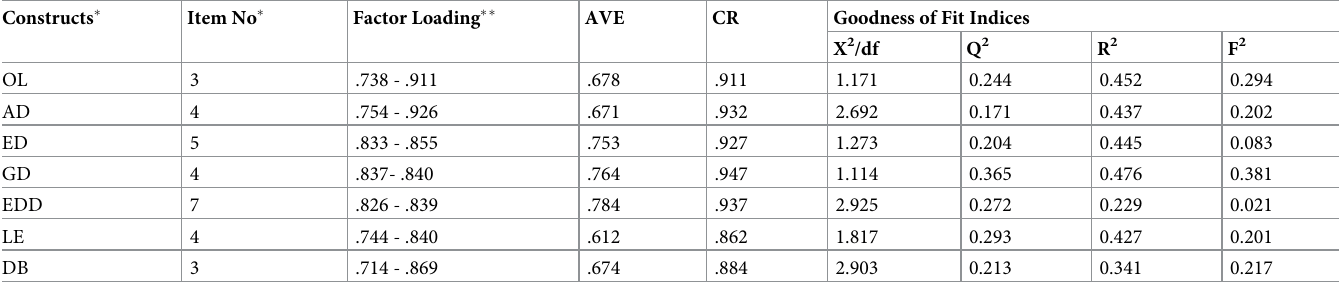
Table 2. Confirmatory factor analysis for research constructs. Constructs �